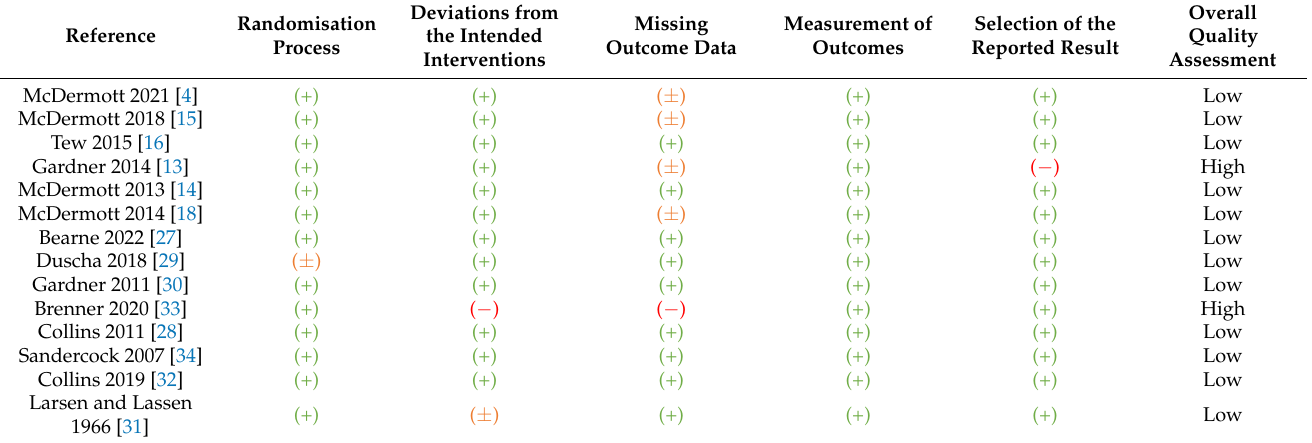
Table 4. Risk of bias assessed using Revised Cochrane risk-of-bias tool for randomized trials (RoB 2).